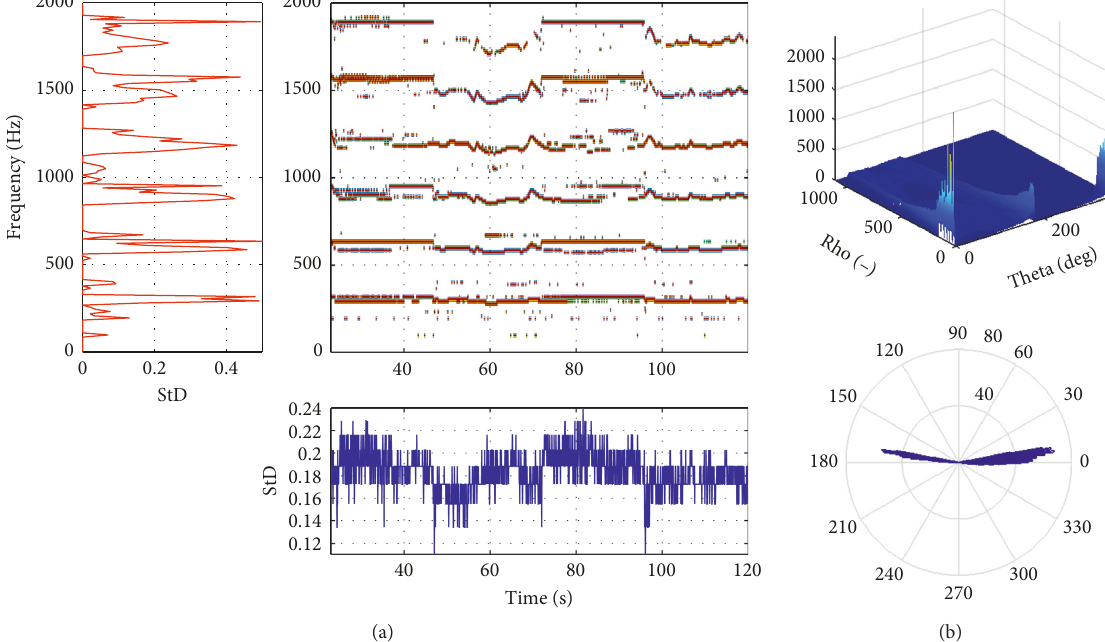
Figure 10: Time-frequency standard deviations (a) and HTdiagram with relevant theta’s polar histogram (b) of the peaks diagram (cropped within effective milling time range) of bed frame acceleration, for the first case of squared